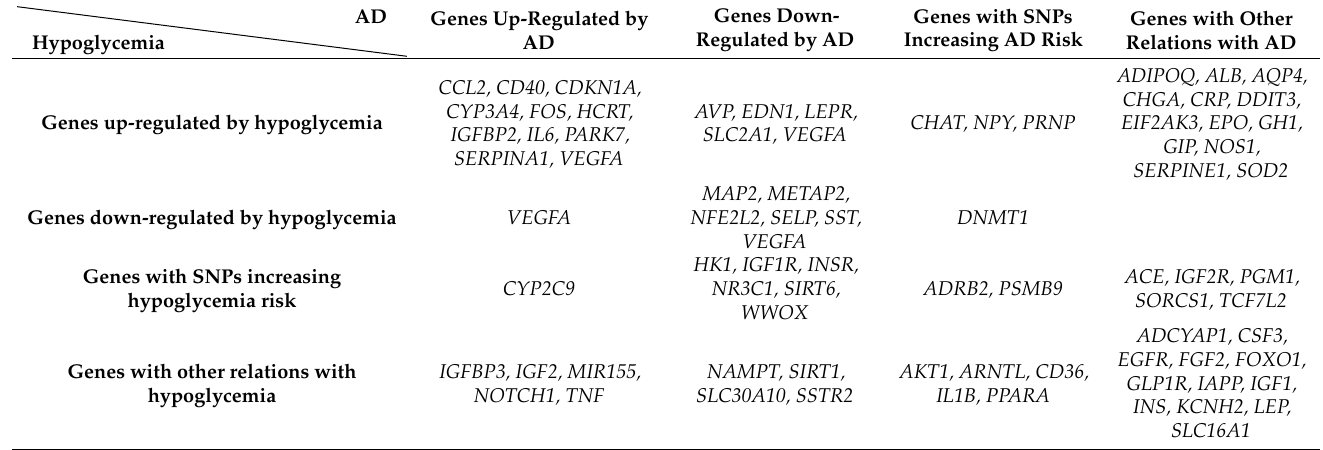
Table 5. Combined analysis of the genes related to hypoglycemia and